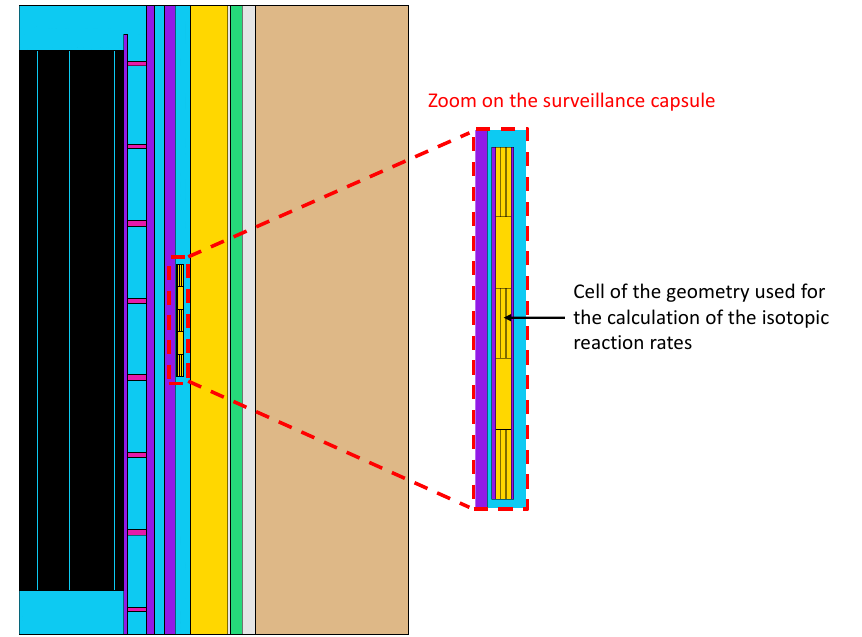
Figure 6. Axial cut of the MCNP6 modeling of the H.B. Robinson-2